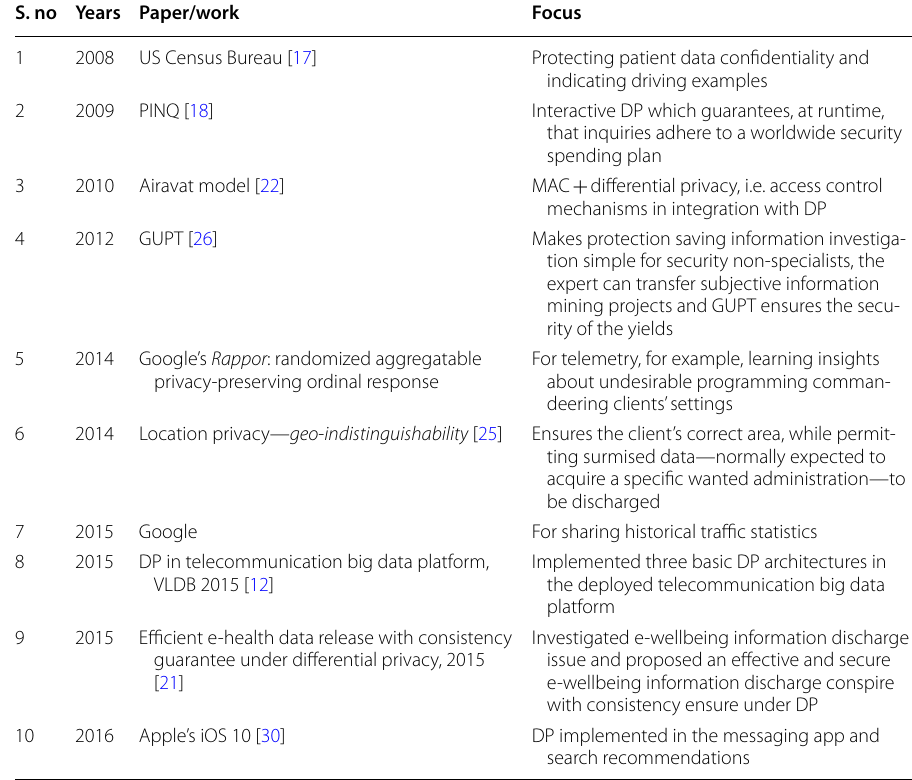
Table 4 Comparative study of different differential privacy mechanism S. no Years